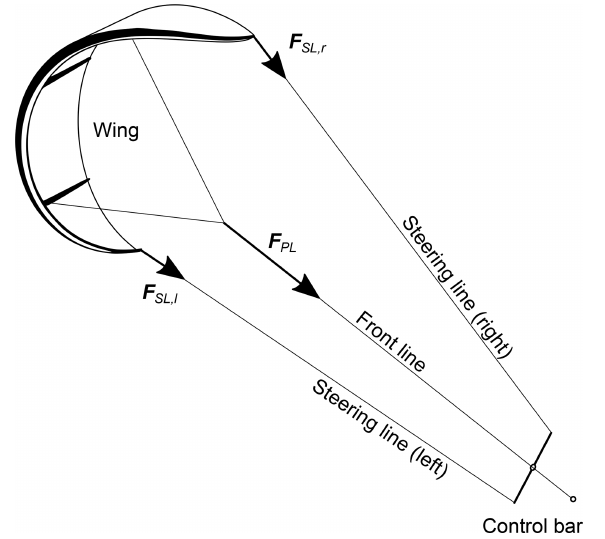
Figure 3. Forces acting in the power and steering